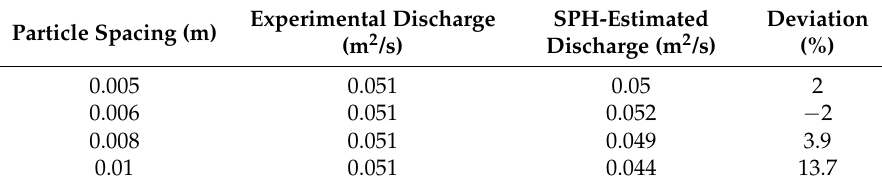
Table 8. Discharge deviation with different particle spacing.